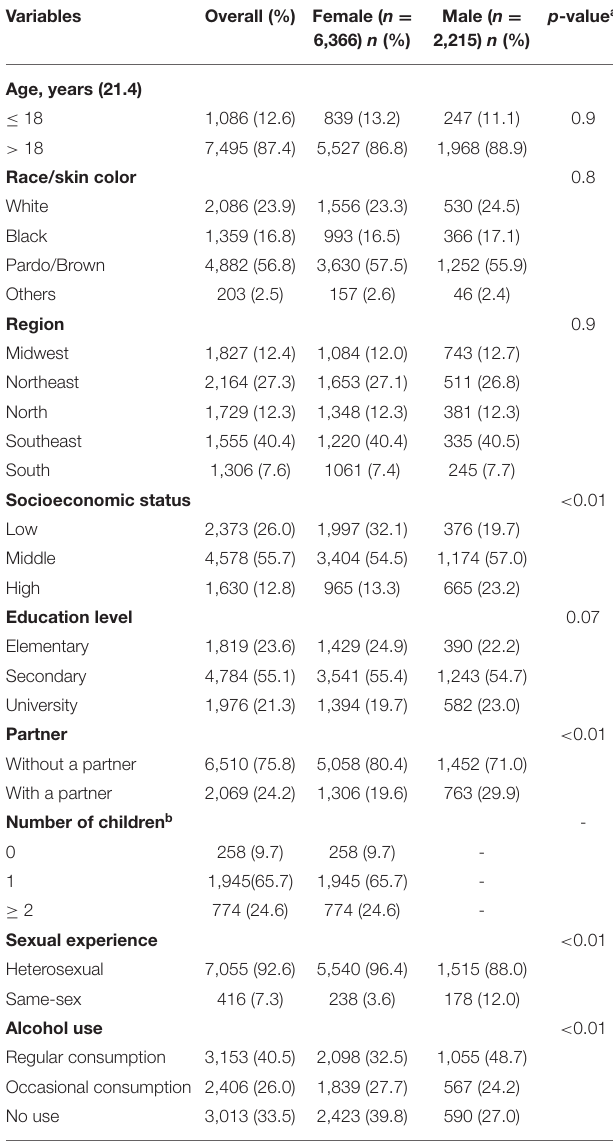
TABLE 1 | Sociodemographic characteristics of the participants aged 16–25 years in Brazil according to sex, 2016–2017.